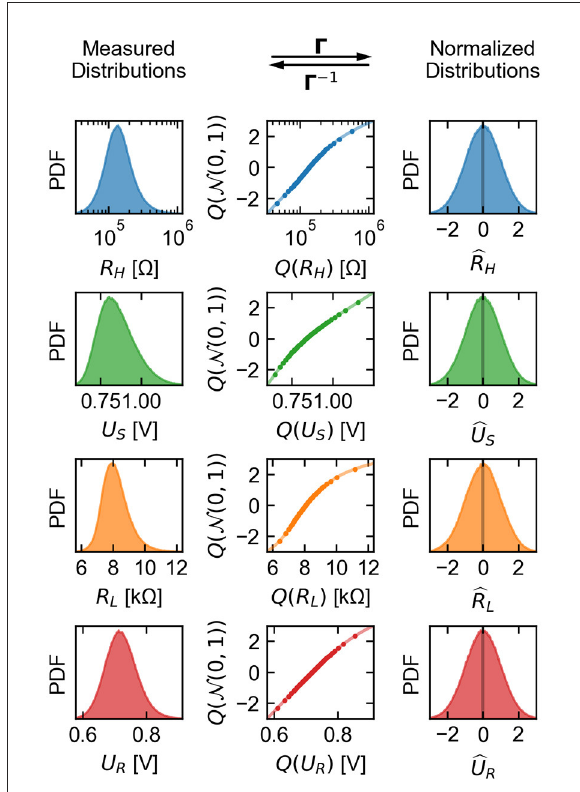
FIGURE8 Visualization of the invertible normalizing transformation Ŵ that is applied to the measured feature vectors before fitting with a base stochastic process. The left column shows the marginal PDFs of the vector time series x n extracted from measurement. The center column shows the input and output quantile-quantile plots with the fitted log-polynomial function used to transform the distributions (here, Q denotes the quantile function of its argument). The right column is the result of applying Ŵ to the input data, producing x n whose elements are normally b